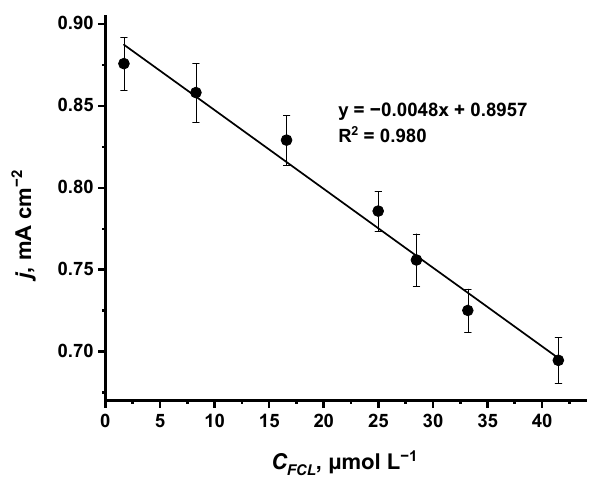
Figure 3. Linear dependency between anodic current peaks (Figure 2) and concentrations of FCL in PBS determined by using the glass|FTO|PB sensor.